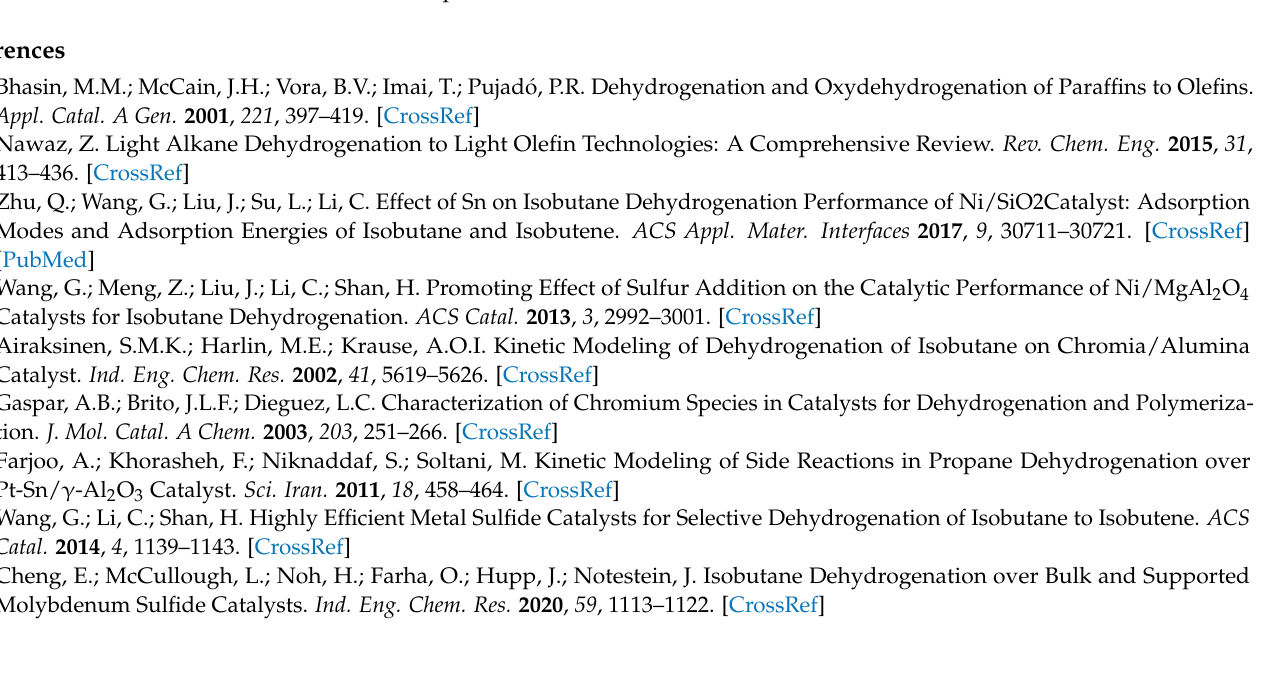
Figure S2: XRD analysis of spent catalysts, Table S1: Crystallite size of spent